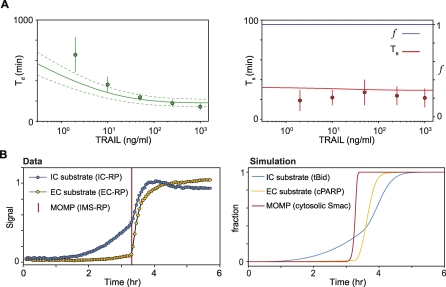
Training Data Derived from Live-Cell Microscopy(A) Simulation of Td (left) or Ts and f (right) as a function of TRAIL dose (lines) alongside corresponding experimental values (points with error bars indicating standard deviations). For predicted values of Td, an envelope of constant coefficient of variation is shown, as estimated from experimental data (CV ≈ 20%); the source of variation is not known.(B) Composite plot of IC-RP and EC-RP cleavage for >50 cells treated with 50 ng/ml TRAIL in the presence of CHX and aligned by the average time of MOMP (left panel) and model-based simulation of the corresponding species (right panel). Data in the left panel were originally reported elsewhere [15].